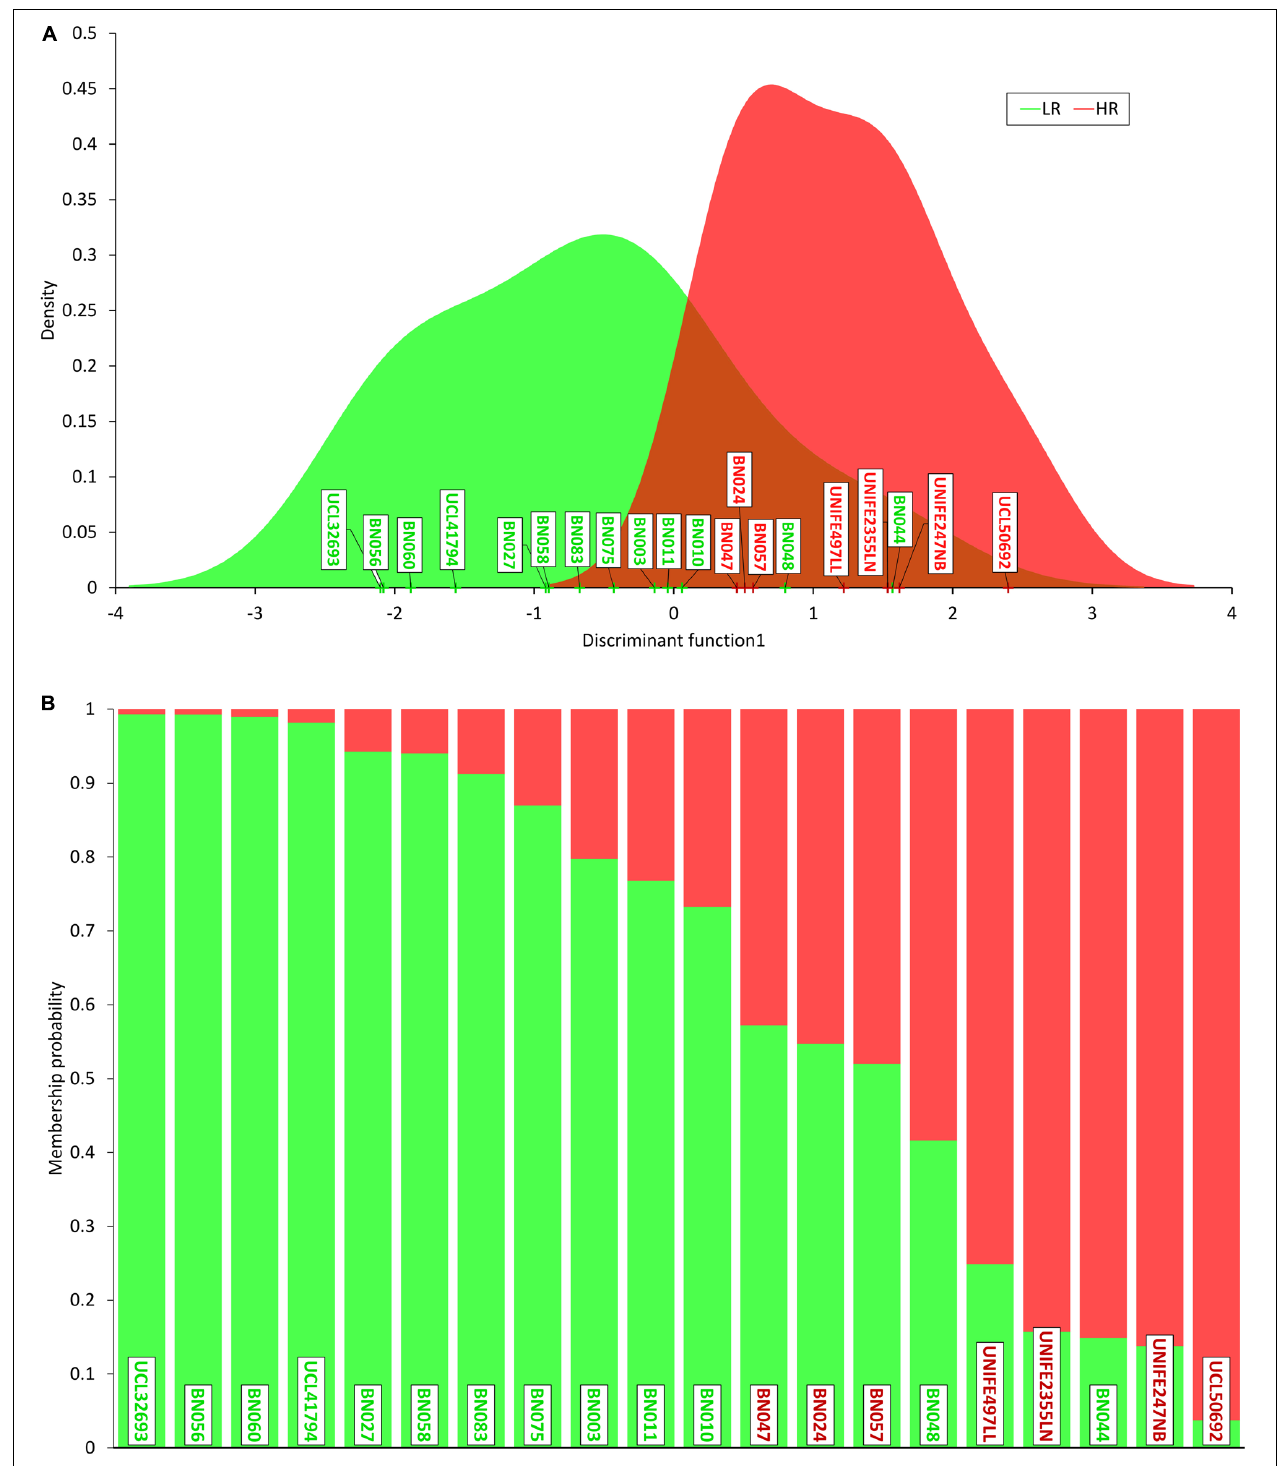
FIGURE 1 | Discriminant analysis of principal components (DAPC). (A) Density of individual scores on the first discriminant function, low responders (LR) in green and high responders (HR) in red; (B) membership probability (assignment) of individuals to the two groups based on the retained discriminant functions. Each individual is represented as a vertical bar, where colors corresponding to probabilities of membership to LR (green) and HR (red). Note that three HR patients show a higher “genetic proximity” to LR cluster and two LR subjects are assigned to HR cluster.